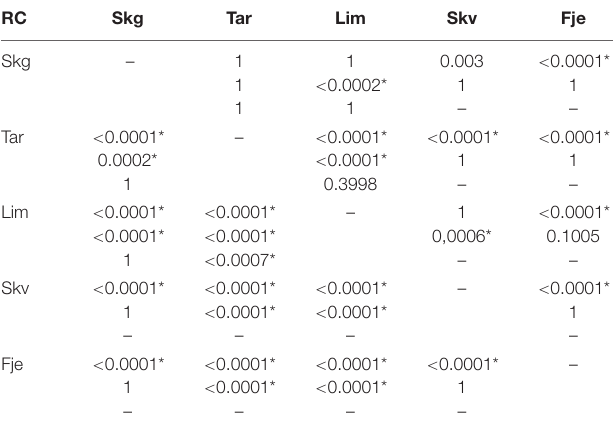
Significantly differing terms are indicated by * at the corrected multiple pairwise comparison alpha of 0.0025 for LO and PB/PZ morphs and of 0.0083 for the PP morph.